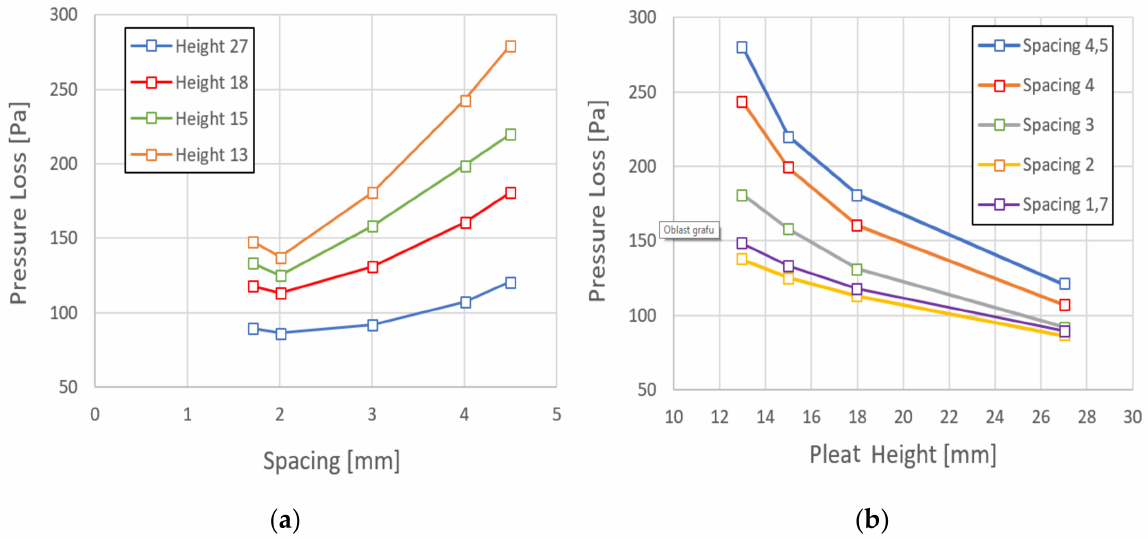
Figure 20. Measured pressure drop of pleated filter at flow rate 70 L/min. ( a ) Pleat height varies between 13 and 27 mm; ( b ) Spacing varies between 1.7 and 4.5 mm.